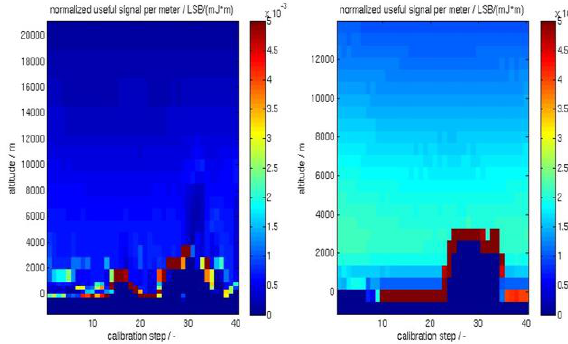
Figure 3 Comparison of normalized Rayleigh useful signal (least significant bit LSB/mJ m) from observations (left) and E2S (right) over Antarctica in nadir-pointing during a response calibration (step# corresponds to distance); high signals (red colors) show ground-return signals over ice.